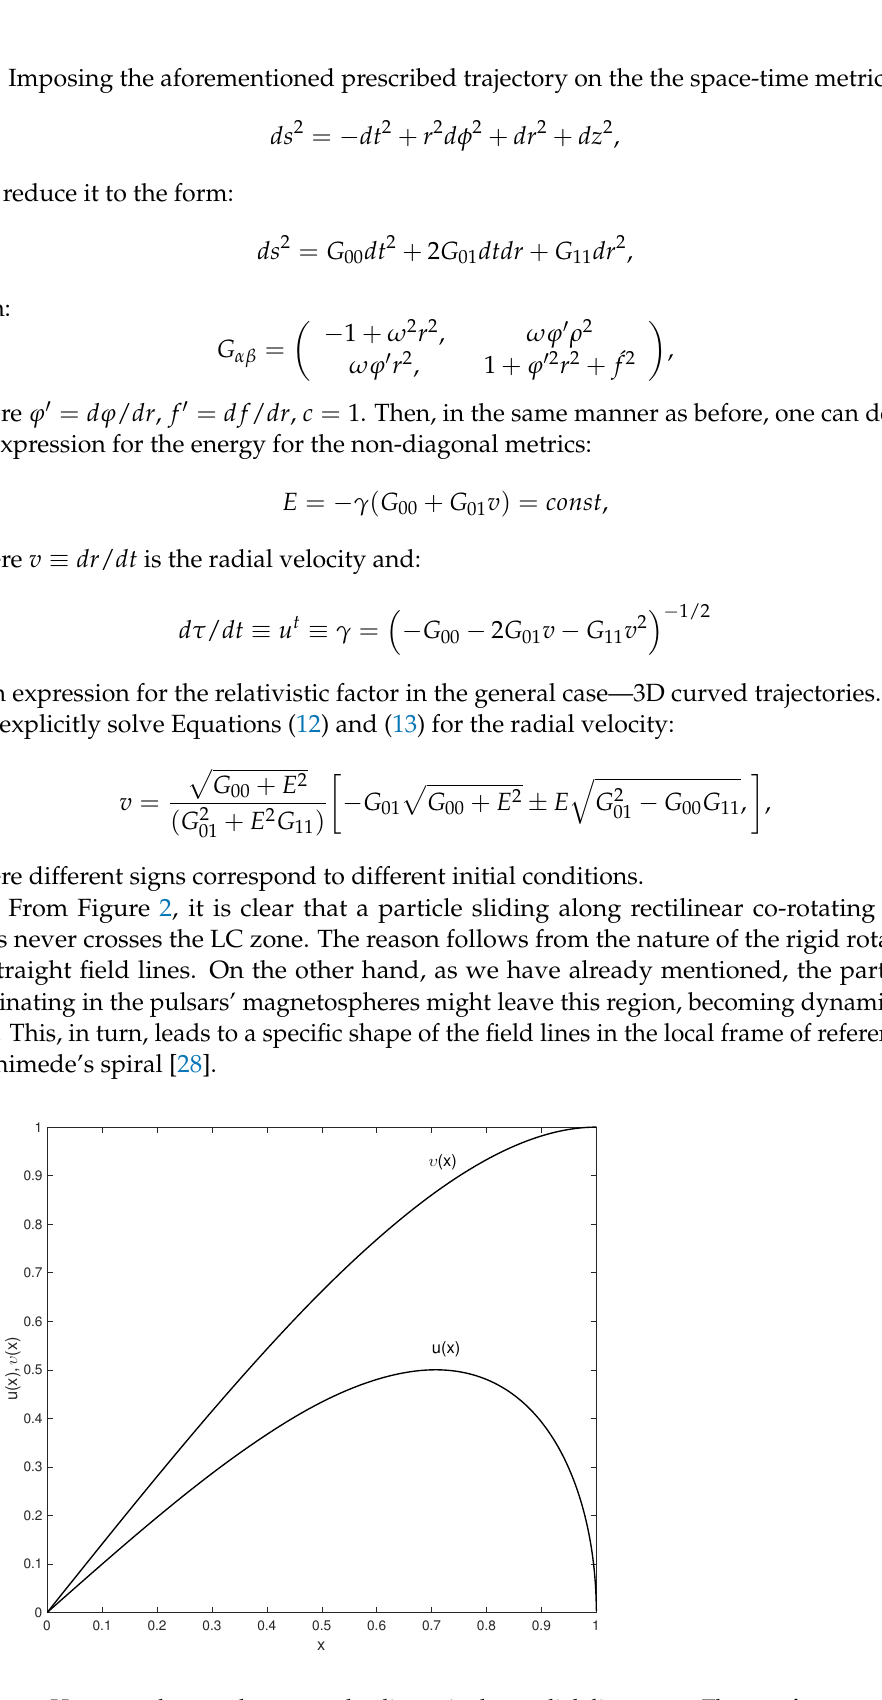
Figure 2. Here, we plot u and υ versus the dimensionless radial distance, x . The set of parameters is x 0 = 0.001 and u 0 =